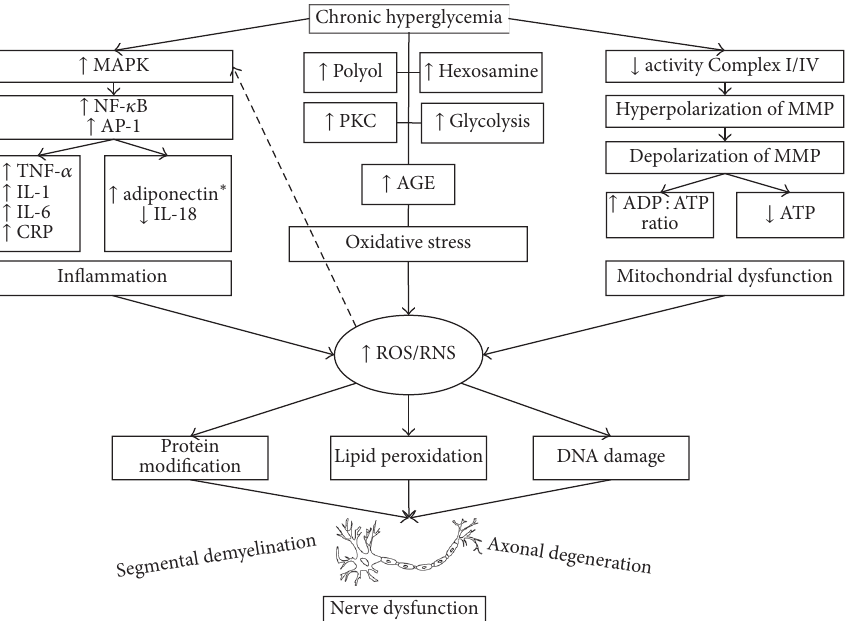
Figure 2: Mechanisms of nerve dysfunction induced by hyperglycemia. The description of how inflammation, oxidative stress, and mitochondrial dysfunction contributes to ROS/RNS formation and nerve damage. ∗ Paradoxical increase of adiponectin in